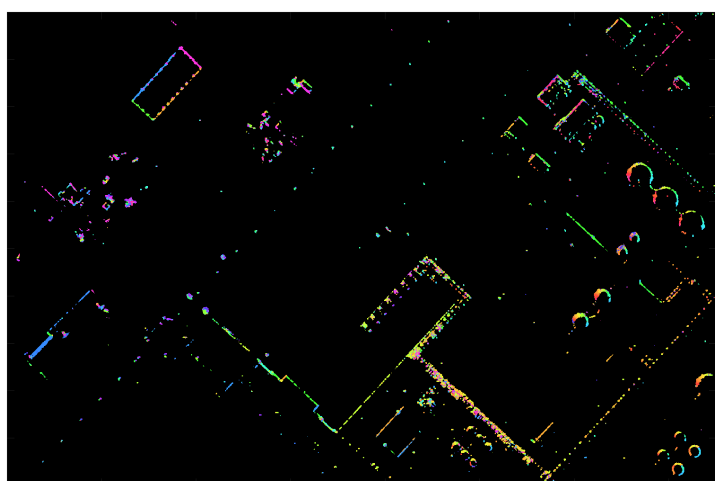
Figure 17. The scattering direction estimation result of the G 0